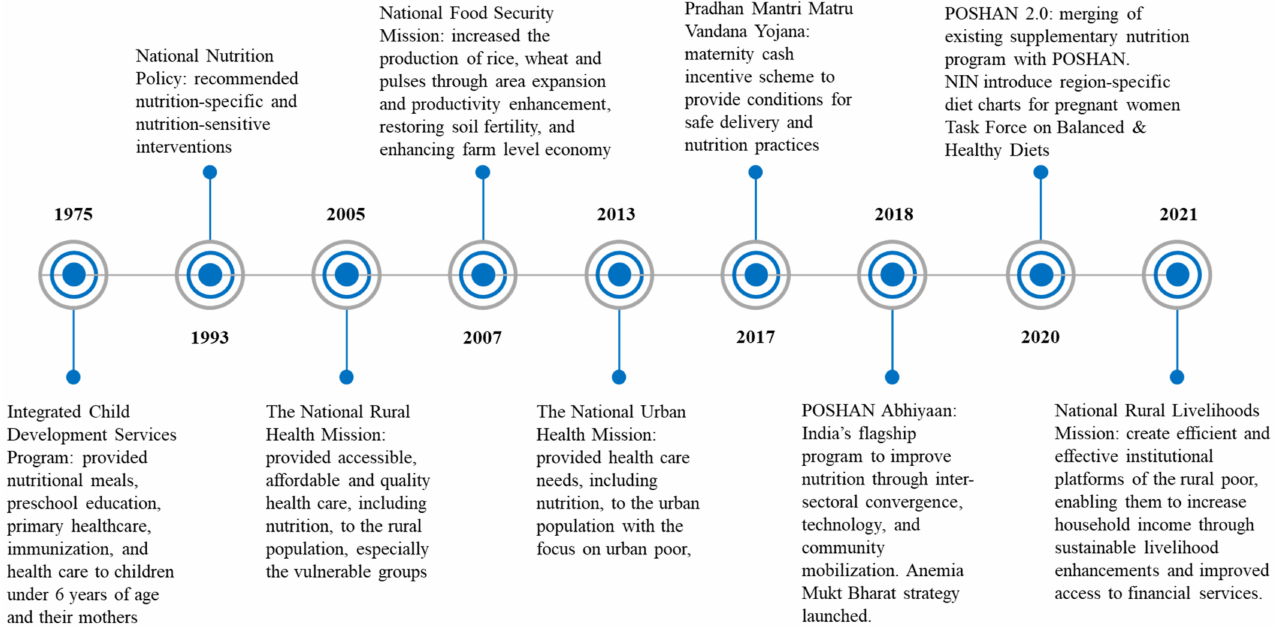
Figure 4. Summary of key policies to improve maternal nutrition and maternal